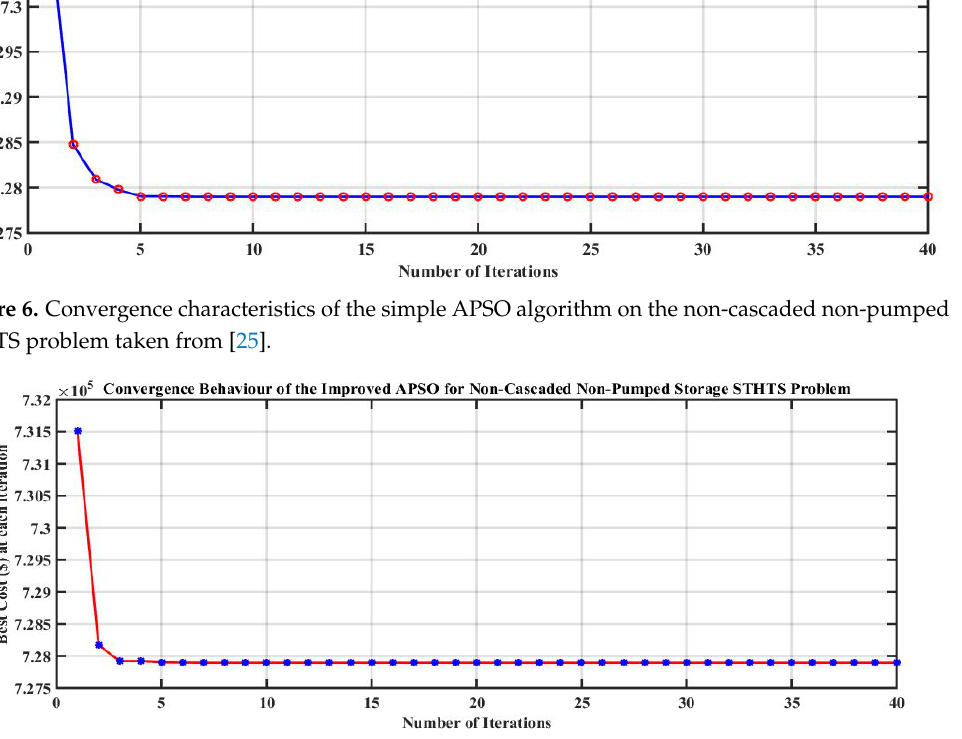
Figure 7. Convergence characteristics of the improved APSO algorithm on the non-cascaded non-pumped STHTS problem.